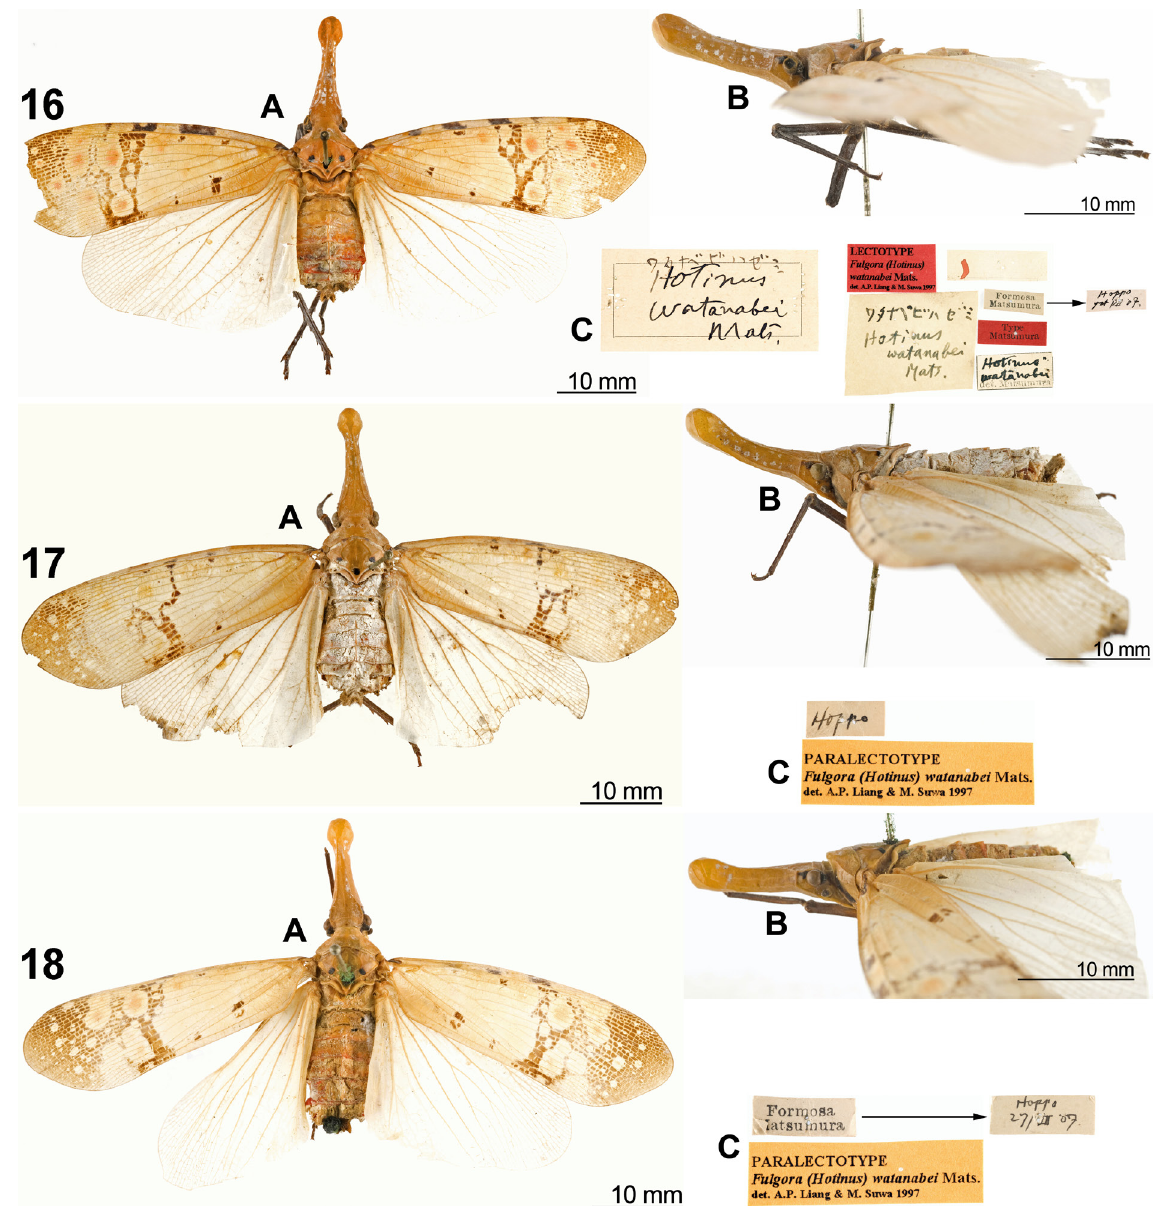
Figs 16–18. Pyrops watanabei (Matsumura, 1913), type specimens of Hotinus watanabei Matsumura, 1913 (photographs by HUIC). 16 . Lectotype, ♀. — 17 . Paralectotype, ♀. — 18 . Paralectotype, ♀. A . Habitus, dorsal view. B . Habitus, left lateral view. C . Labels (arrow indicates the reverse of the